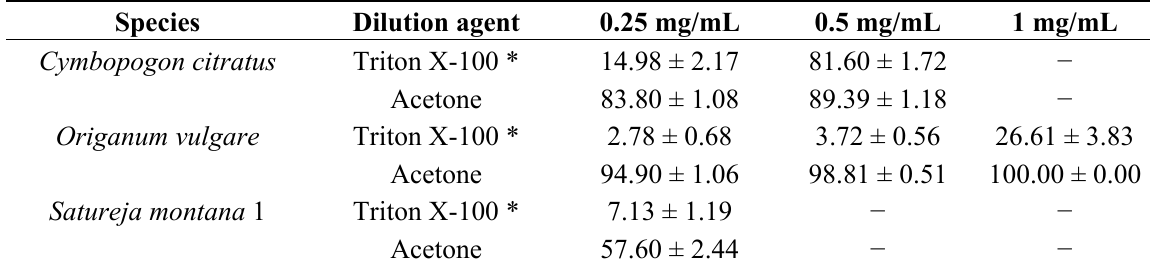
Table 1. Bursaphelenchus xylophilus mortality (mean ± SE, in percentage) when significant differences were found between the use of Triton X-100 and acetone as dilution agents of essential oils ( p ≤